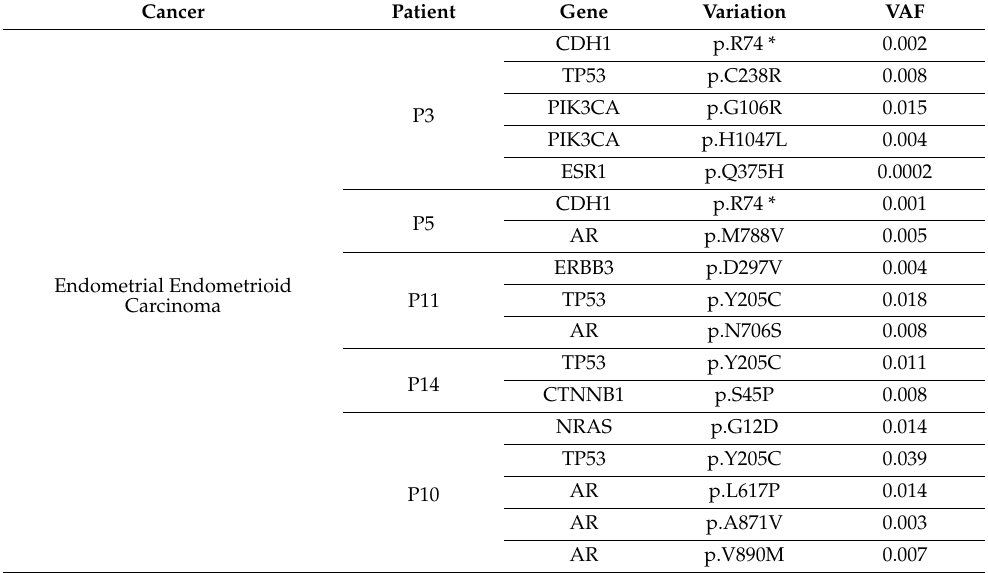
Figure 6. Expression of different molecular markers in a patient with vaginal small cell carcinoma. A genomic mutation in TP53 was observed in P10, P11, and P14. A mutation in CDH1 was observed in P3 and P5. Two breast cancer patients (P8 and P16) had the BRCA1 mutation (Table 6). Table 6. Genomic expression of seven patients.